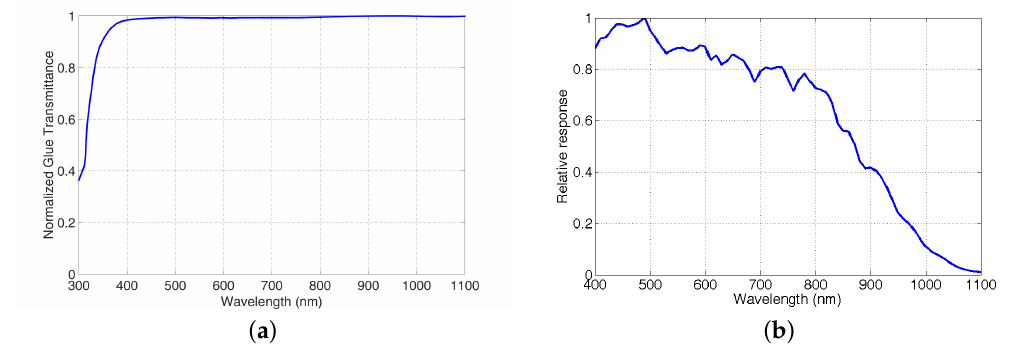
Figure 3. Glue transmittance ( a ) and sensor efficiency of the CMOS sensor EV76C661 ( b